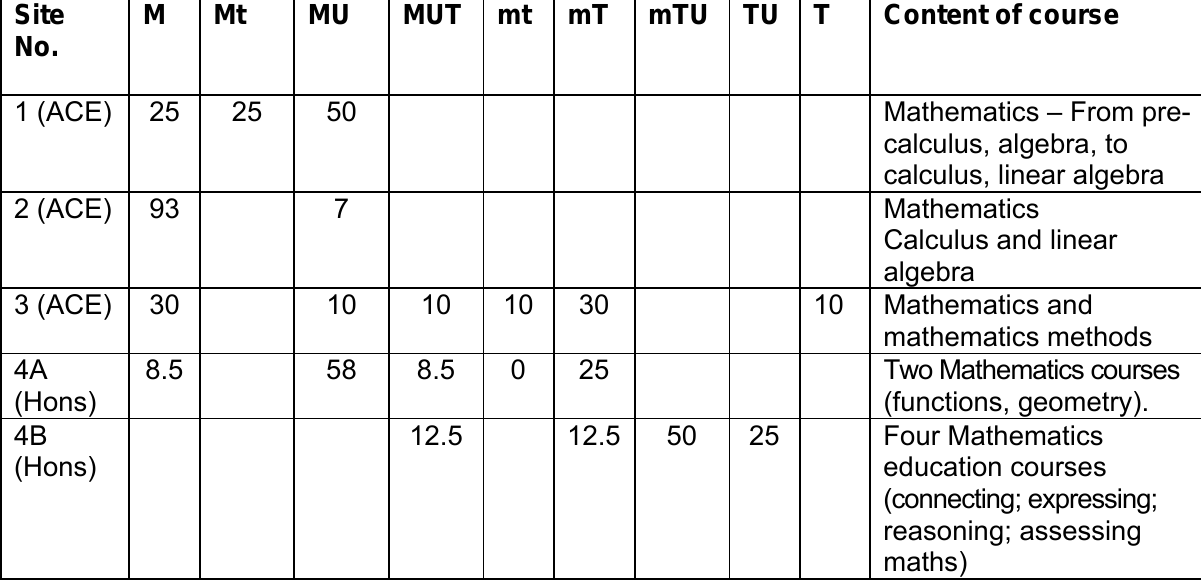
Table 1: Categorisation of tasks in course assignments across sites, expressed as a percentage of the total number of tasks in each site/set of